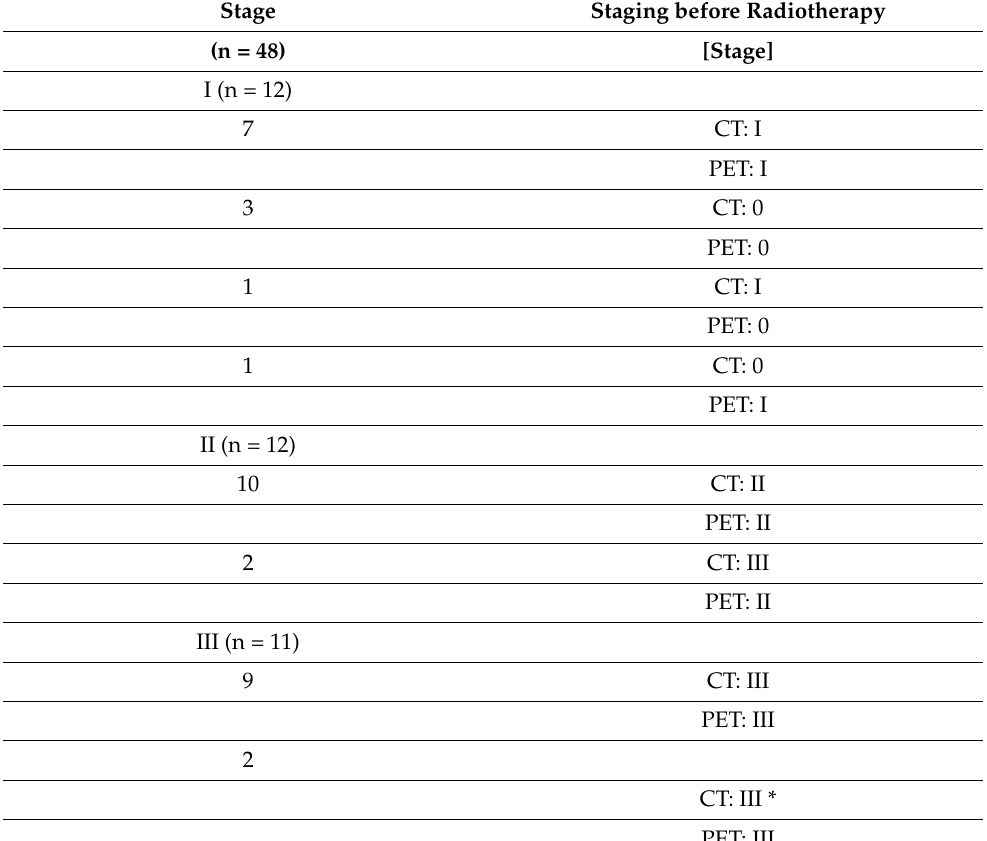
Table 5. Staging before